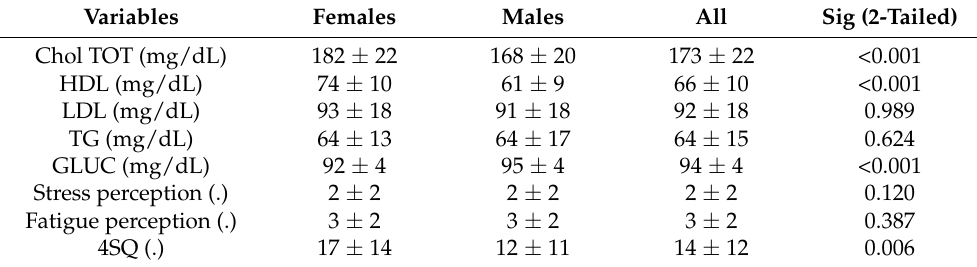
Table 4. Major metabolic and subjective stress indicators: summary statistics (median ± MAD) and Mann–Whitney test. Variables Females Males All Sig (2-Tailed) Chol TOT (mg/dL)